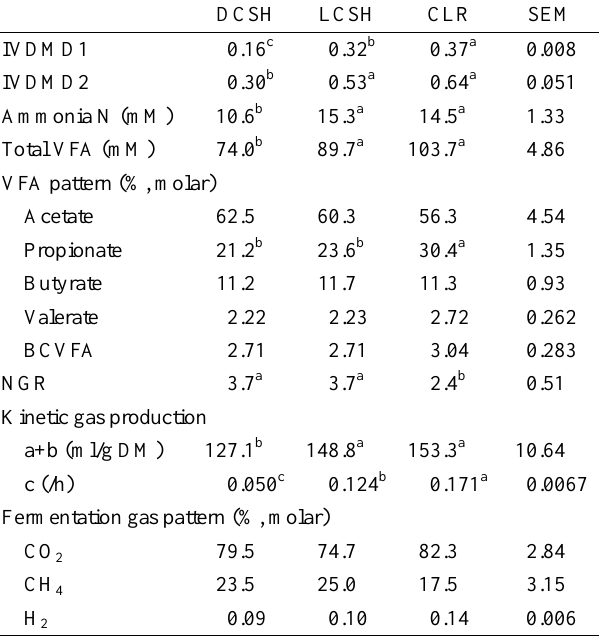
Table 4 . In vitro dry matter digestibility and fermentation characteristics of delinted cottonseed hulls (DCSH), linted cottonseed hulls (LCSH) and cottonseed linter residue